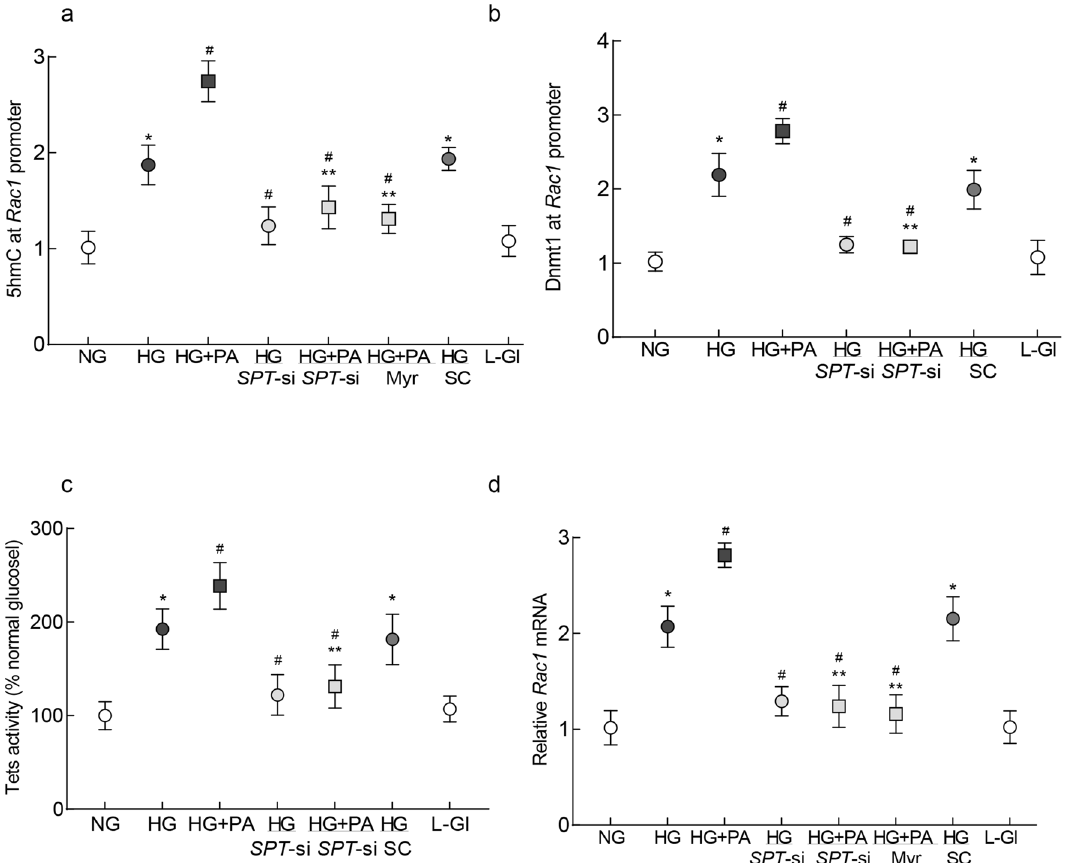
Figure 4. Regulation of SPT and transcriptional activation of Rac1 in HRECs. ( a ) 5hmC levels at Rac1 promoter were quantified using hydroxyl-methylated DNA immunoprecipitation technique, and ( b ) binding of Dnmt1 at Rac1 promoter by ChIP assay using IgG as a negative antibody control. ( c ) Activity of Tets was measured by TET Activity/Inhibition Assay Kit, and ( d ) relative Rac1 mRNA by qRT-PCR using β-actin as a housekeeping gene. Values are represented as mean ± SD from 3–4 cell preparations, with each measurement made in duplicate. NG and HG = 5 mM or 20 mM d-glucose; HG + PA = 20 mM d-glucose + palmitic acid; HG/ SPT -si and HG + PA/ SPT -si = SPT -siRNA transfected cells in 20 mM d-glucose or 20 mM d-glucose + palmitic acid; HG + PA/Myr = 20 mM d-glucose + palmitic acid + Myriocin; HG/SC = SPT -scrambled control RNA transfected cells in 20 mM d-glucose; L-Gl = 20 mM l-glucose. *p < 0.05 vs NG, # p < 0.05 vs HG and # **p < 0.05 vs HG +